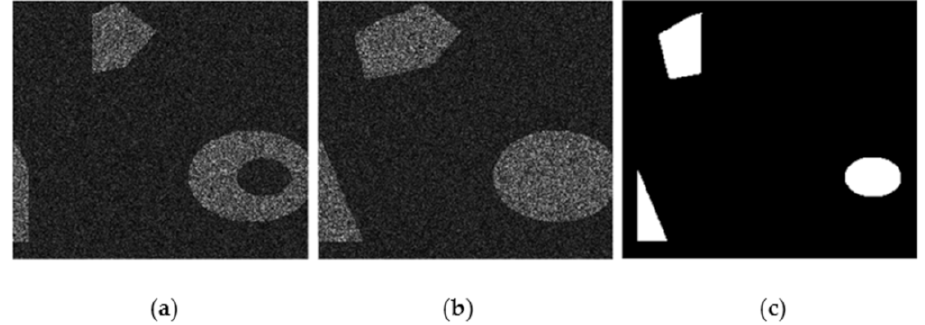
Figure 9. Simulated SAR images. ( a , b ) Simulated SAR images. ( c ) Ground truth image.